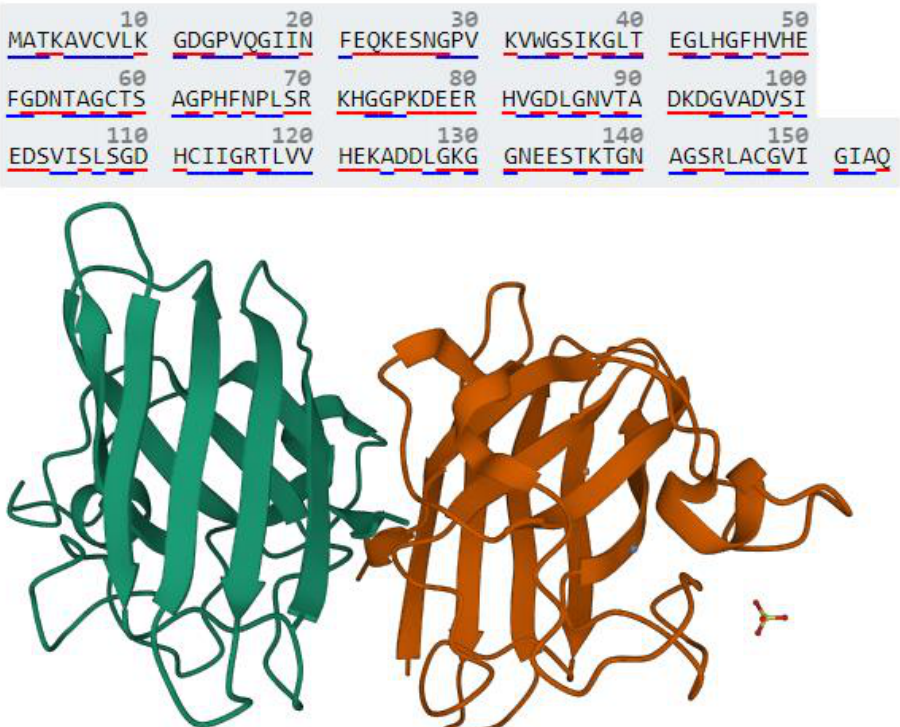
Figure 1. Amino acid sequence and three-dimensional structure of SOD1 (PDB ID: 1PU0). SOD1 is a 32 kDa homodimer protein of 154 amino acids. The red underline of amino acid letters indicates polar residues, while the blue underline indicates hydrophobic residues.